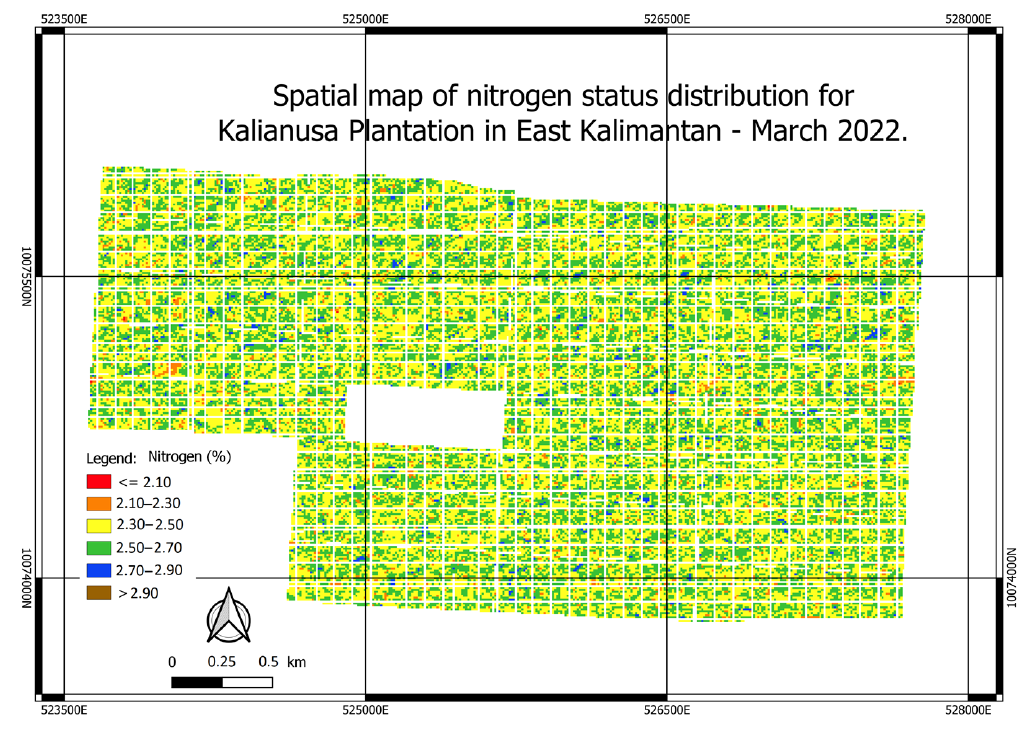
Figure 8. Spatial map of nitrogen status distribution for Kalianusa plantation in East Kalimantan March 2022.